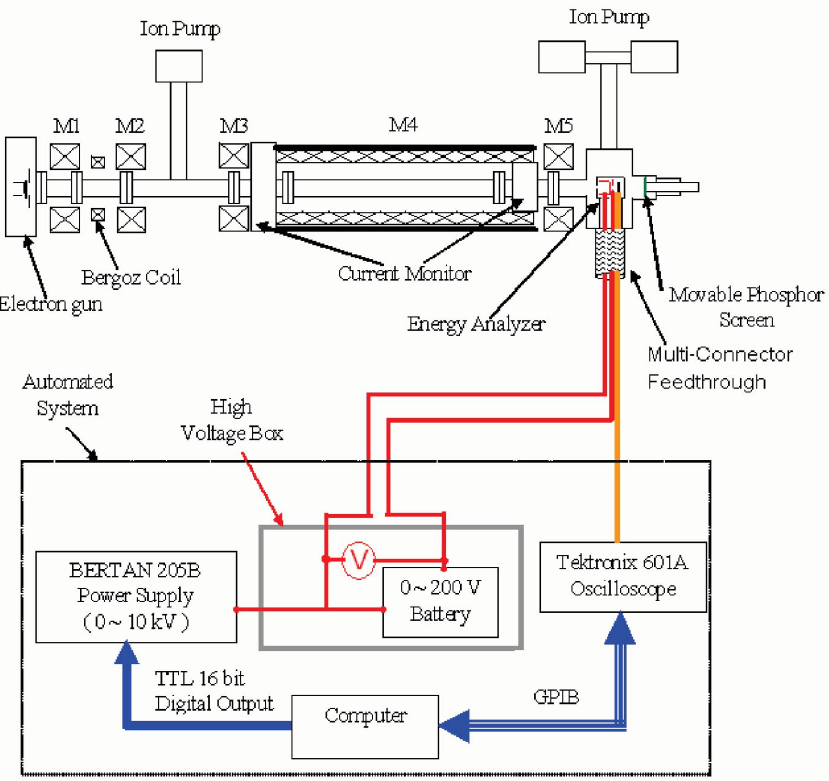
FIG. 1. (Color) Schematic of the long solenoid experiment system